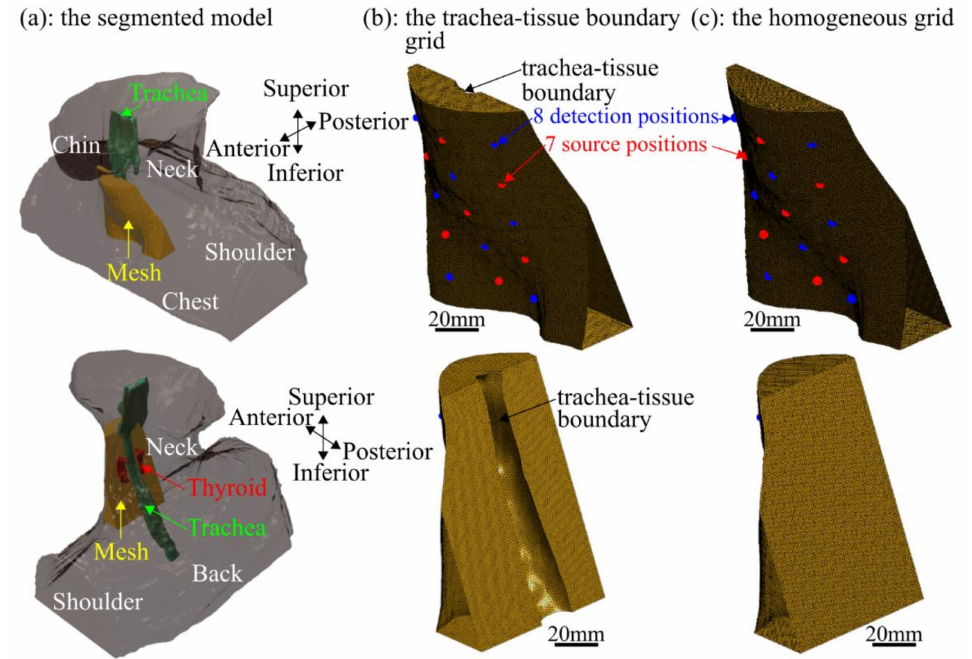
Figure 3. Front (top) and back views (bottom) of the segmented model and grids used for image reconstruction. ( a ) Seg- mented model from the MR image: the neck and body (gray), the trachea (green), the thyroid (red), and the approximate location of the grid (yellow). ( b ) Trachea–tissue boundary grid. The source positions (red) and detection positions (blue) are also shown. ( c ) Homogeneous grid. The source positions (red) and detection positions (blue) are also